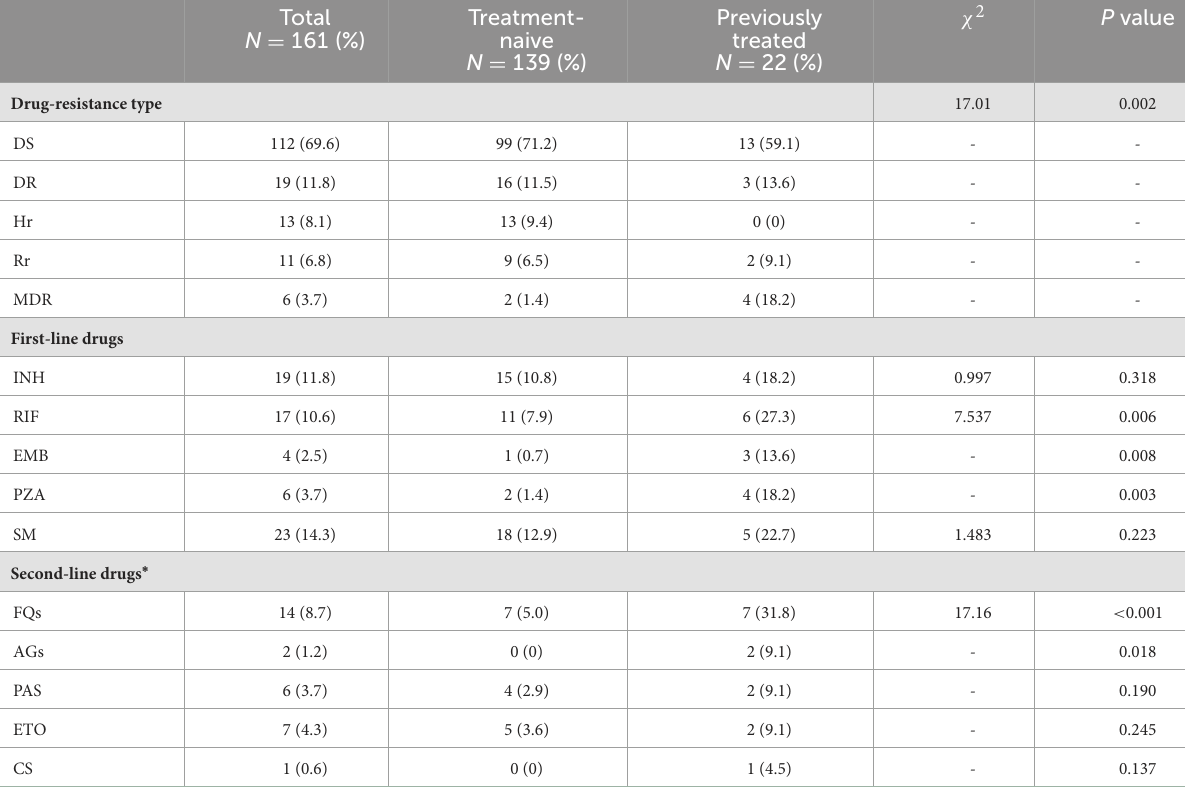
TABLE 2 Drug resistance spectrum of primary and retreated tuberculosis patients.